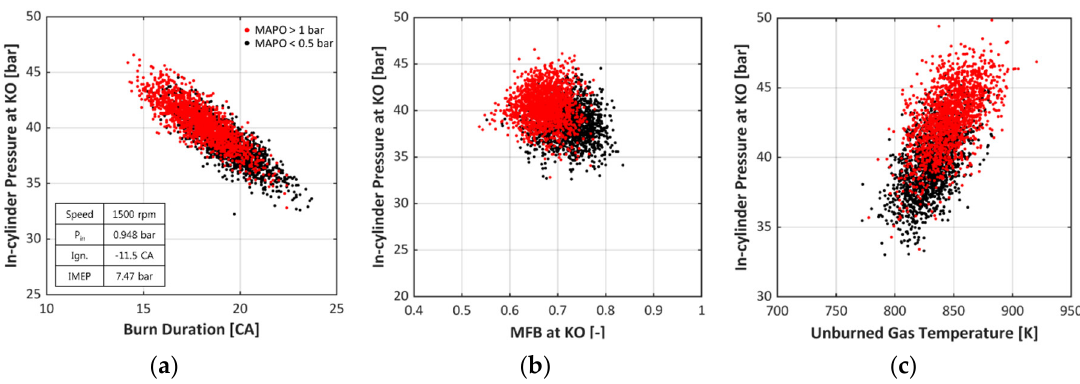
Figure 15. Result of individual cycle analysis: ( a ) P cyl @KO and MFB; ( b ) P cyl @KO and MFB; ( c ) P cyl @KO and unburned gas temperature. MFB: mass fraction burned.